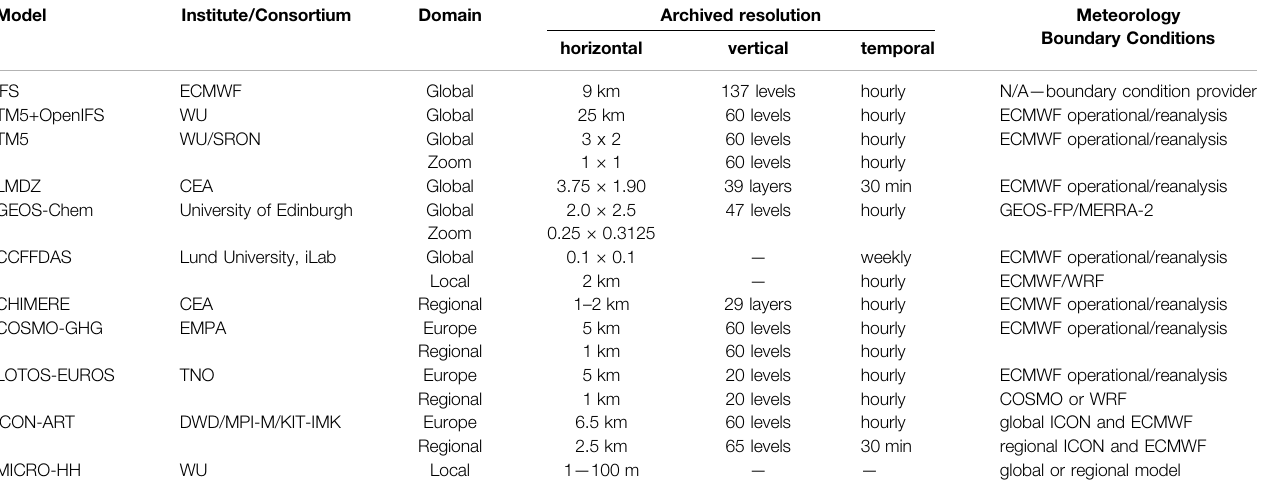
TABLE 1 | Global and Regional Modelling Systems participating to the CO 2 prototype phase (from the H2020 CHE and CoCO2 projects).